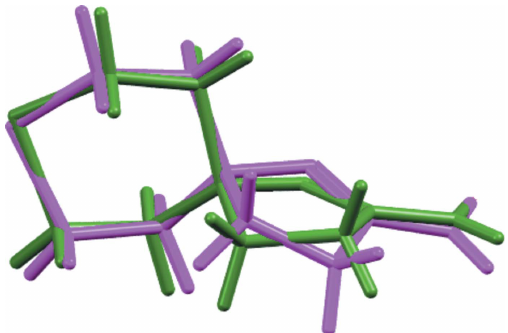
Figure 3 The two independent 2-amino-8-thia-1,5-diazaspiro[4.5]dec-1-en-5-ium cations observed in APOBOX depicted as overlaid